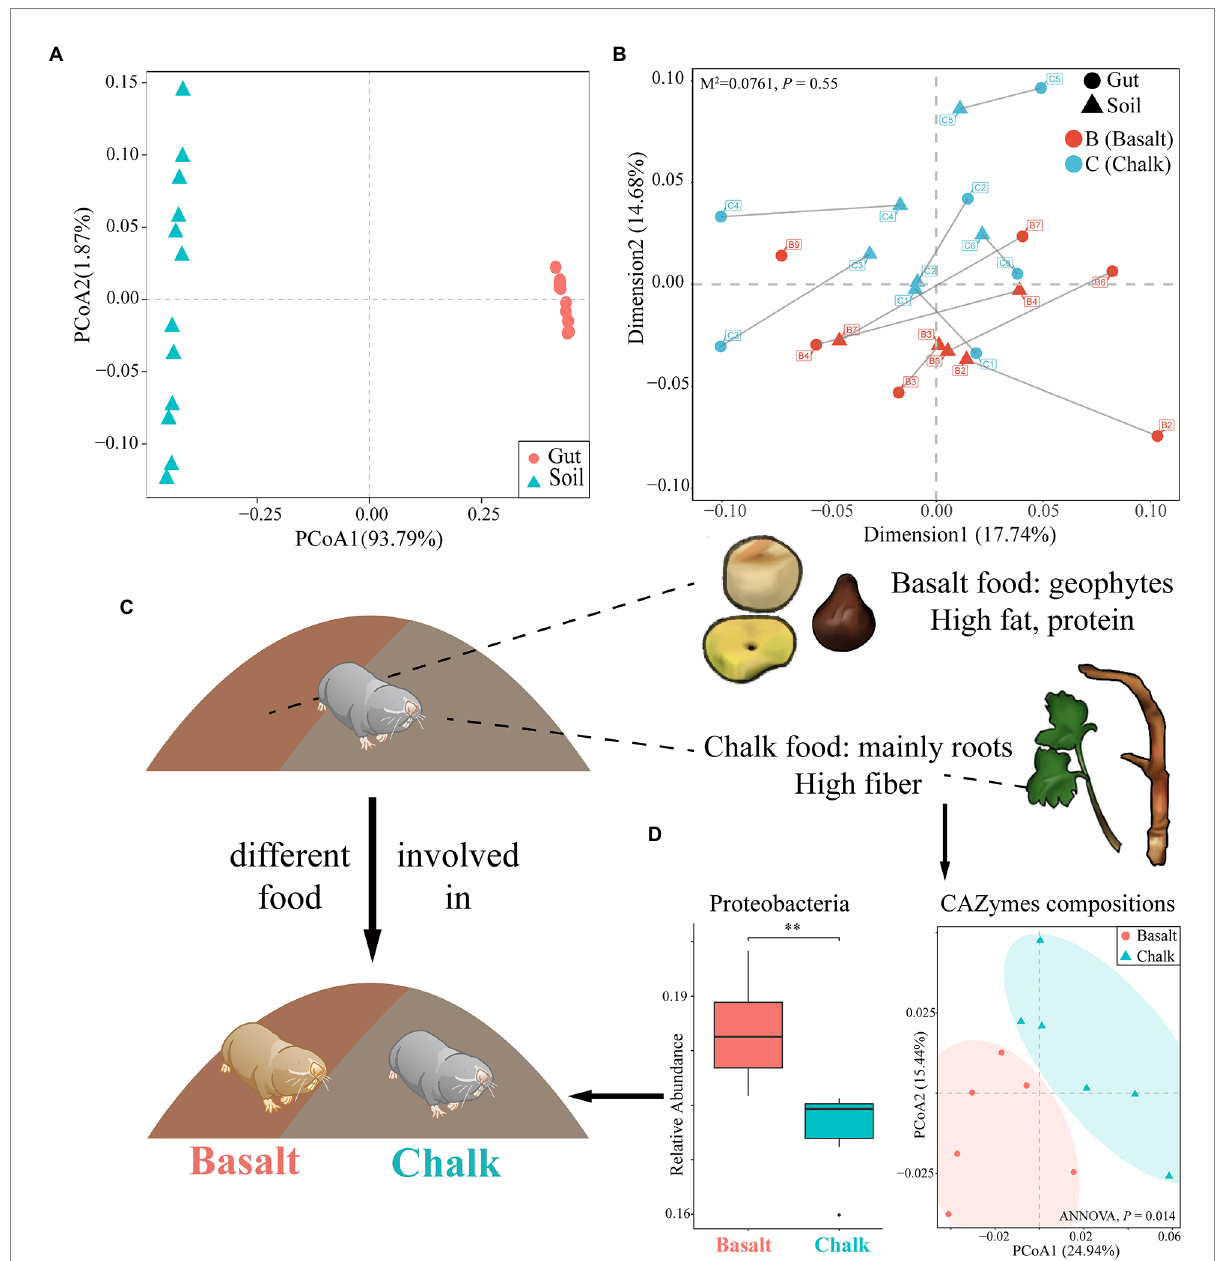
FIGURE 2 The effect of host diet, phylogeny and soil metagenomics on the gut microbiome. (A) Principal component analysis showed that the community composition of gut and soil differ significantly. (B) Procuster analysis showed no correlation in abundance between gut microbiome composition and soil microbiome composition. (C) The emergence of new habitats was followed by new foods, which may have been involved in host divergence. Basalt’s diet was primarily geophytes, rich in fat and protein; chalk’s diet was mainly roots, rich in fiber. This also shaped their gut microbiome. (D) The basalt was richer in Proteobacteria, and the CAZymes compositions of the two were significantly different, which are characteristics of their adaptation to different diets. ** p